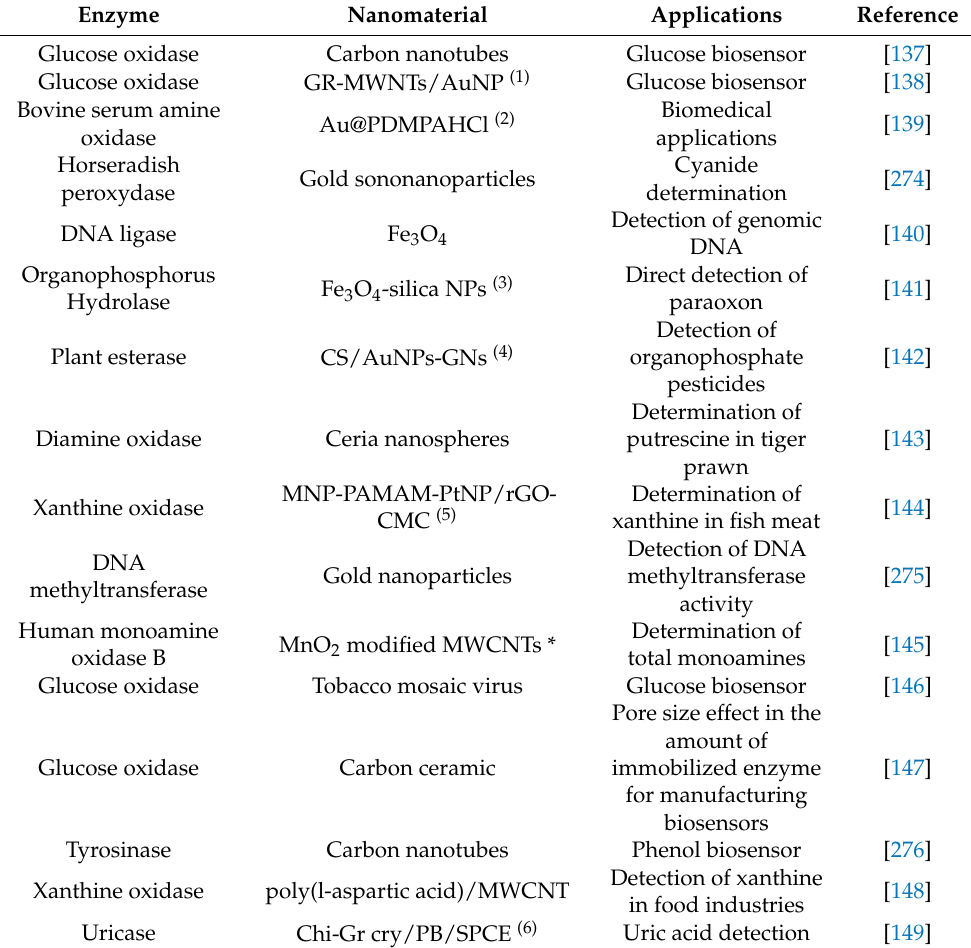
Table 2. Nanomaterial-based enzyme biosensors for different